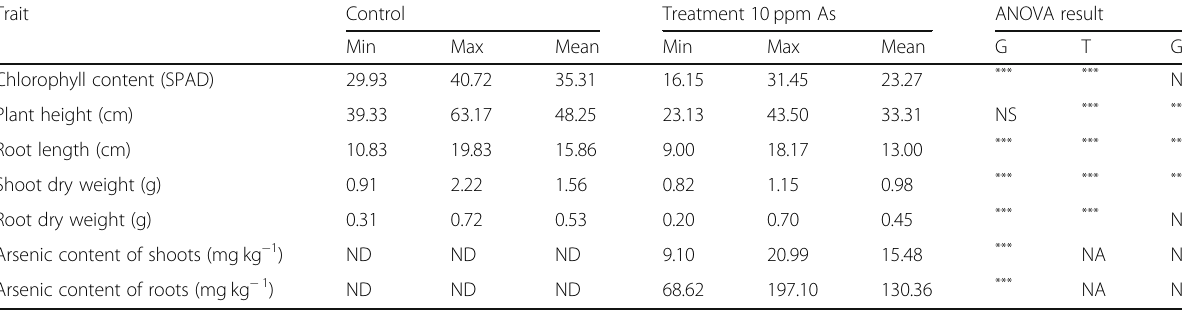
Table 1 Descriptive statistics and ANOVA results for different phenotypes Trait Control